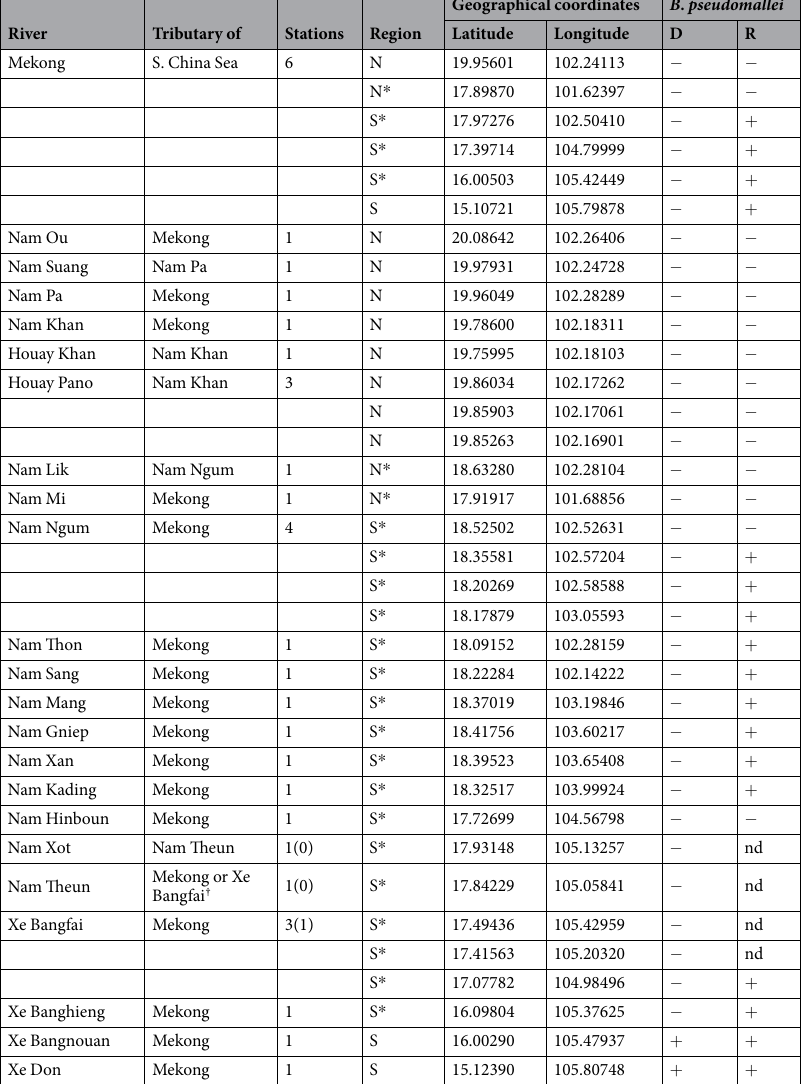
Table 1. Sampled rivers and stations in Laos. Stations: number of sampled stations in the dry season (rainy season in brackets if different). Region: geographical classification based on 38,39 ; stations marked * belong to the centre of Laos (reference: Department of Tourism Marketing, Ministry of Information, Laos). B . pseudomallei : presence of B . pseudomallei by at least one detection method in river water and/or sediment. N = north, S = south, D = dry season, R = rainy season, nd = no data. † Flow direction depends on water level regulations of the Nam Theun dam lake. Geographical coordinates in degrees (WGS 1984) (dry